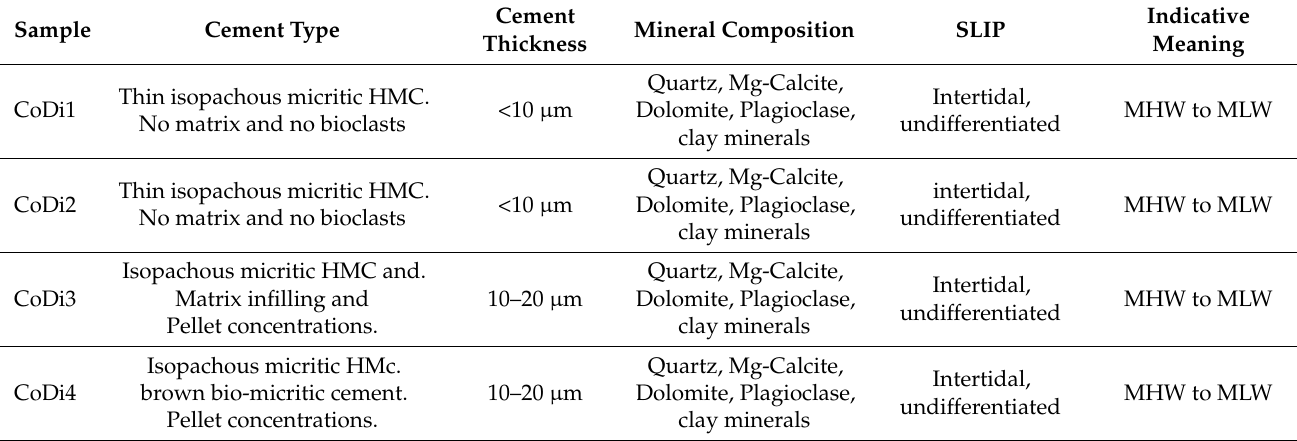
Table 1. Mineral content and textural characteristics of beachrocks derived from the microscopical analysis and association with SLIP and indicative